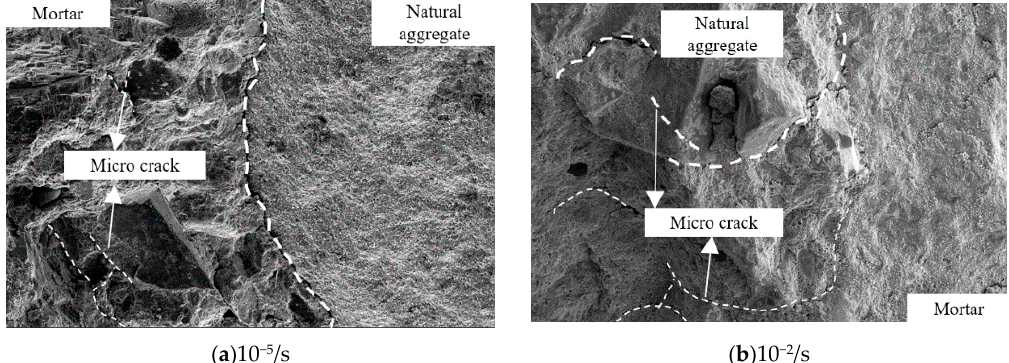
Figure 4. Microscopic failure pattern of self-compacting concrete (SCC) under different loading strain rates.